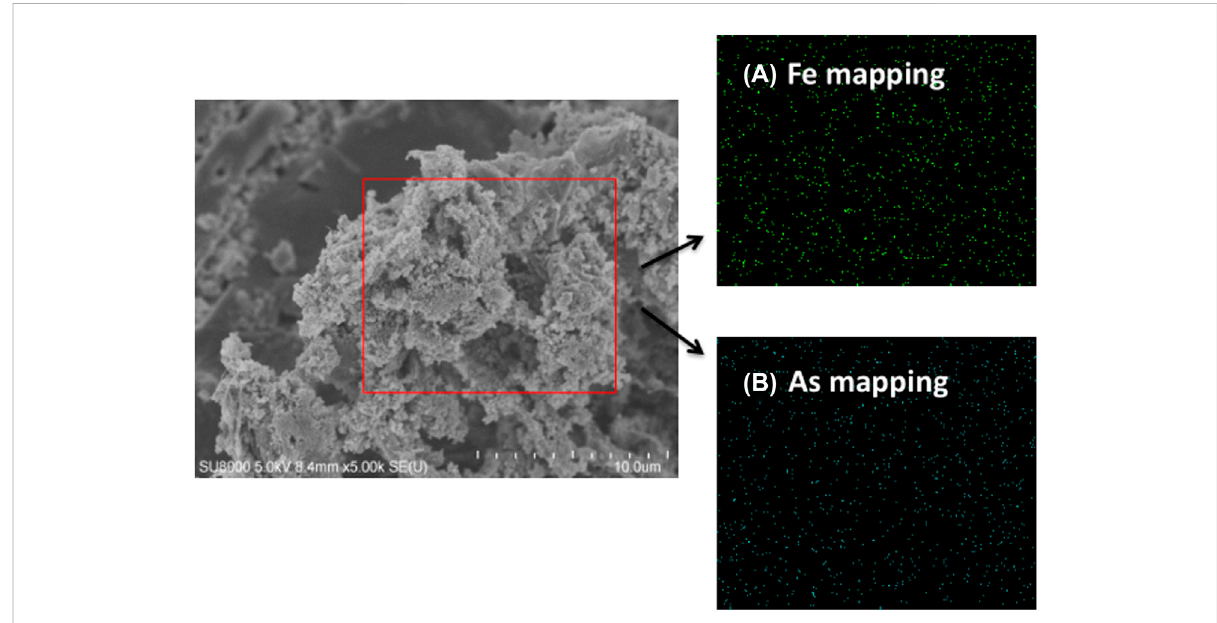
FIGURE 6 FESEM micrograph and elemental mapping of Fe-PE after adsorption. (A) Mapping of iron element and (B) mapping of arsenic element.